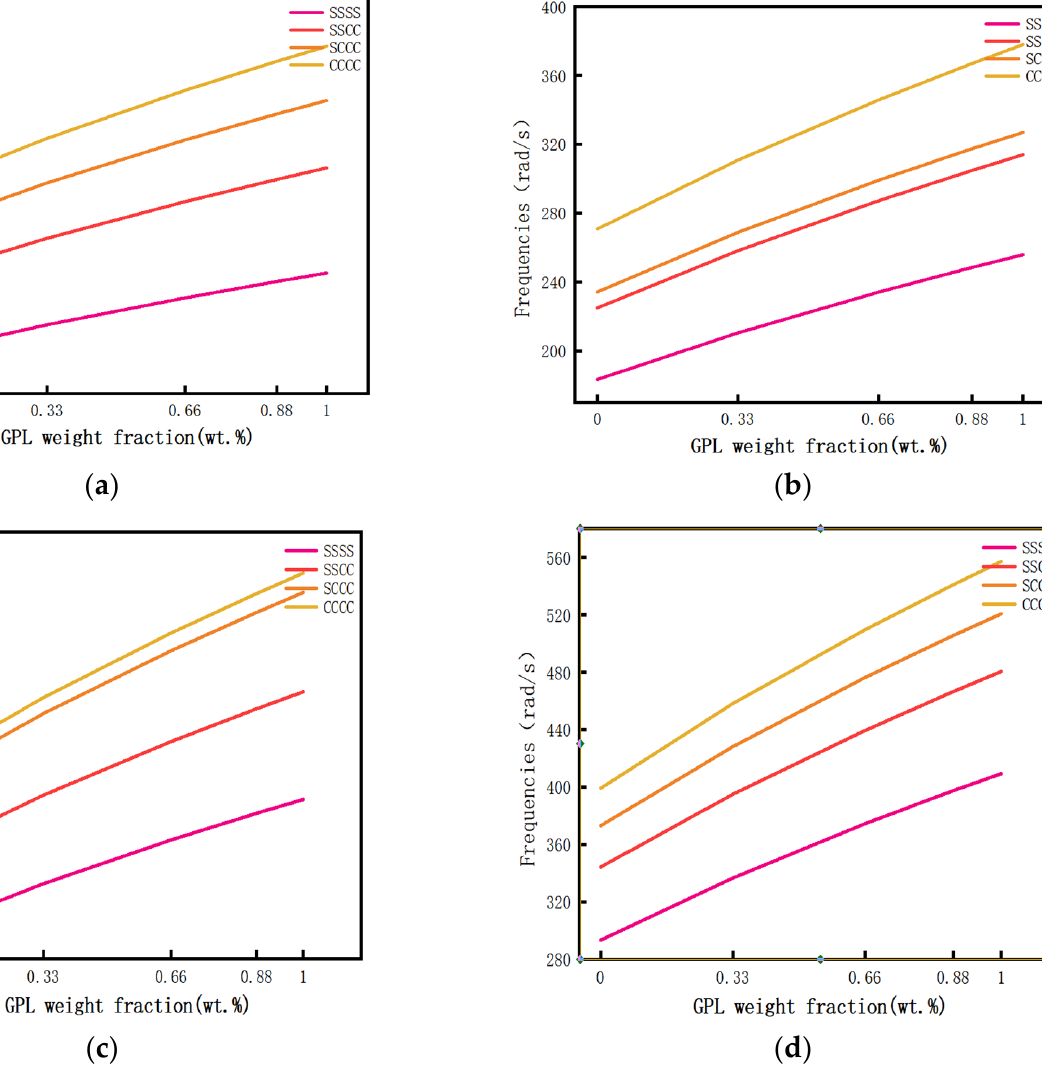
Figure 7. The relationship curve between GPL weight fraction and free vibration frequency. ( a ) First order vibration mode, ( b ) second order vibration mode, ( c ) third order vibration mode, and ( d ) fourth order vibration mode. Calculate the influence of different L GPL / T GPL ratios on the first four-order free vi-